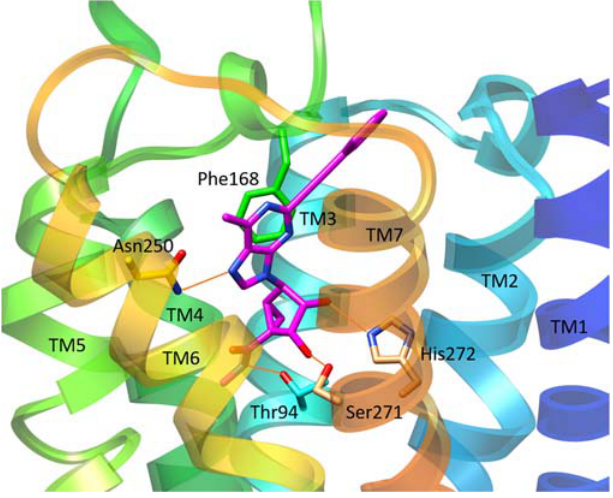
Figure 5. Docking pose of 6 ‐ Me analogue MRS5919 ( 13 , magenta) at the hA 3 AR (hybrid homology model, A 2A AR ‐β 2 template) [23]. H ‐ bond interactions are represented as orange solid lines. The residue Ballesteros–Weinstein notation [18] is: Thr94 (3.36), Phe168 (EL2), Asn250 (6.55), His272 (7.43), Ser271 (7.42) and His272